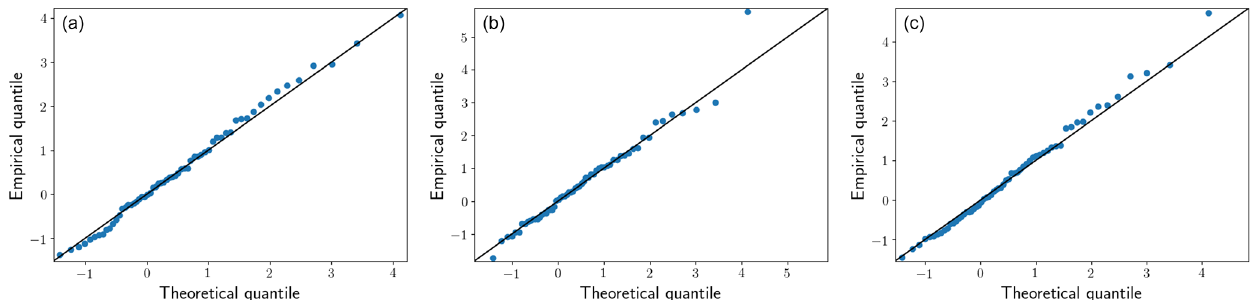
Figure B1. Q – Q plots of the selected models for the three time series displayed in Fig. 1. (a) Ubaye massif at 900m fitted with the model M ζ . (b) Vercors massif at 1800m fitted with the model M ζ 0